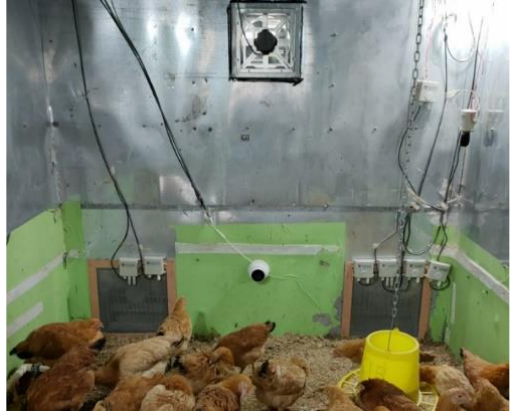
Figure 12. The negative pressure fan was set for the optimization scheme.